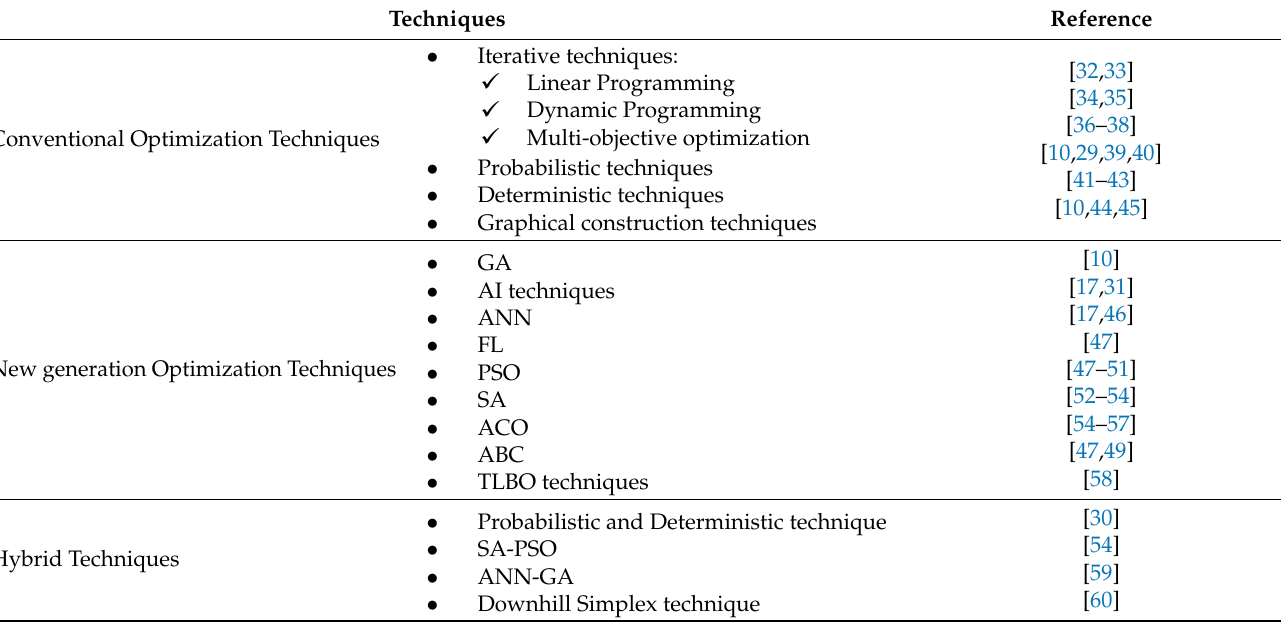
Table 1. Modeling techniques overview.